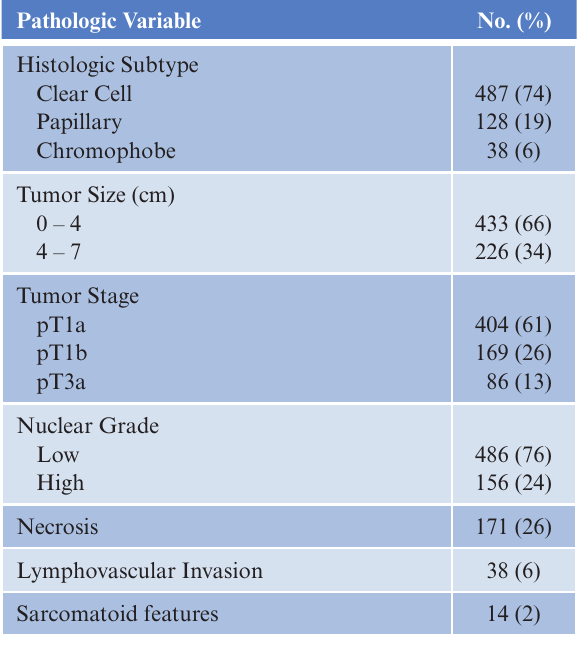
Table 1: Pathologic characteristics of 659 RCC tumors ≤ 7cm in